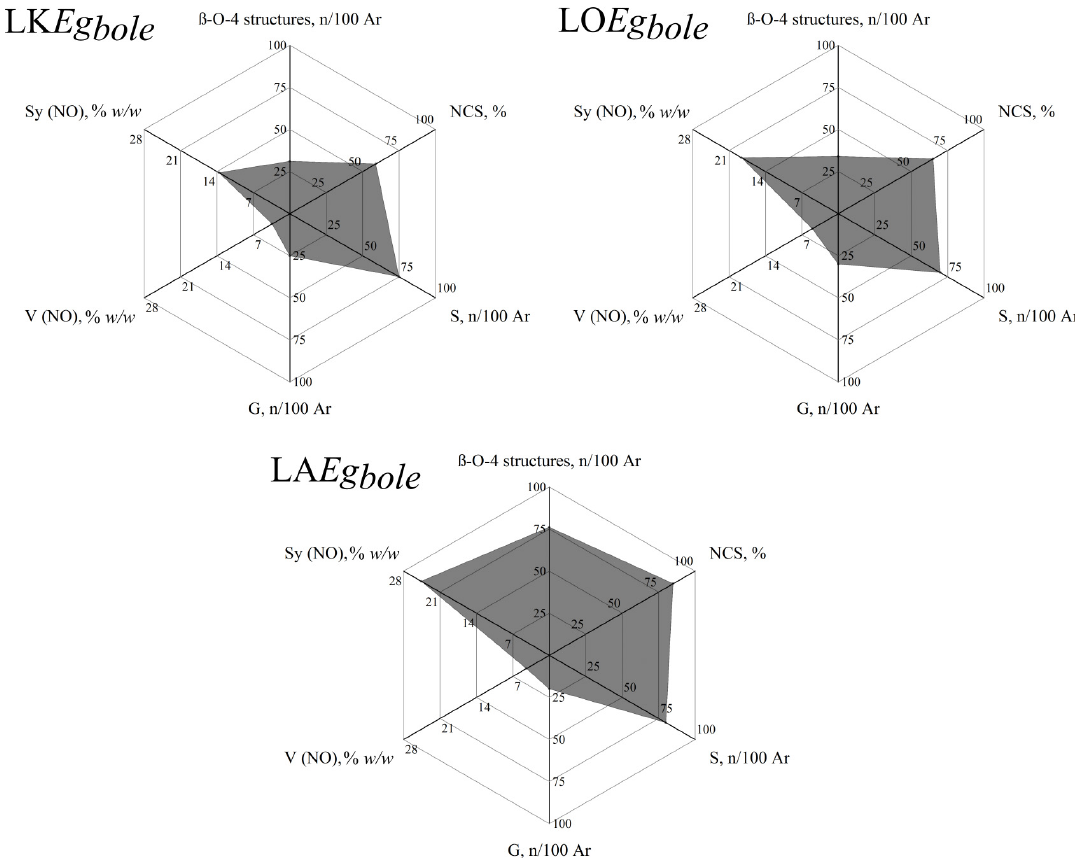
Figure 3. Radar classification for eucalyptus bole lignins produced by different processes (LKEgbole—lignin from industrial Kraft liquor of eucalyptus bole; LOEgbole—lignin produced by ethanol organosolv process of eucalyptus bole; LAEgbole—lignin isolated by mild acidolysis from eucalyptus bole). (Reprinted with permission from [26]. Copyright 2015 American Chemical Society.)